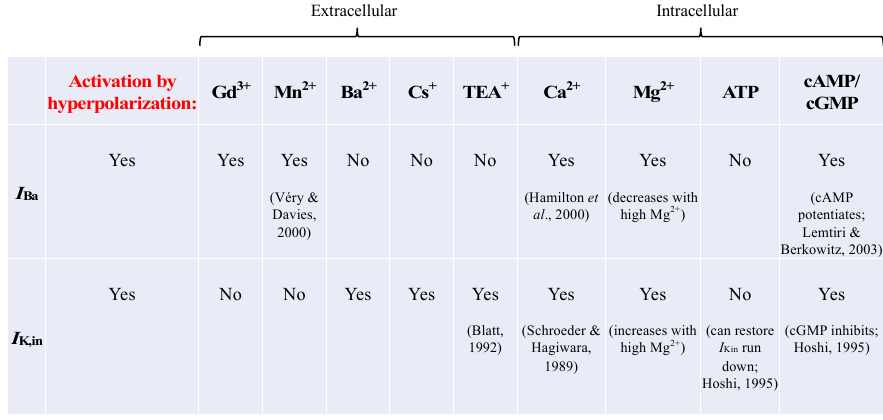
Figure 9. Overview of the properties of the hyperpolarization-activated calcium channels (HACCs).